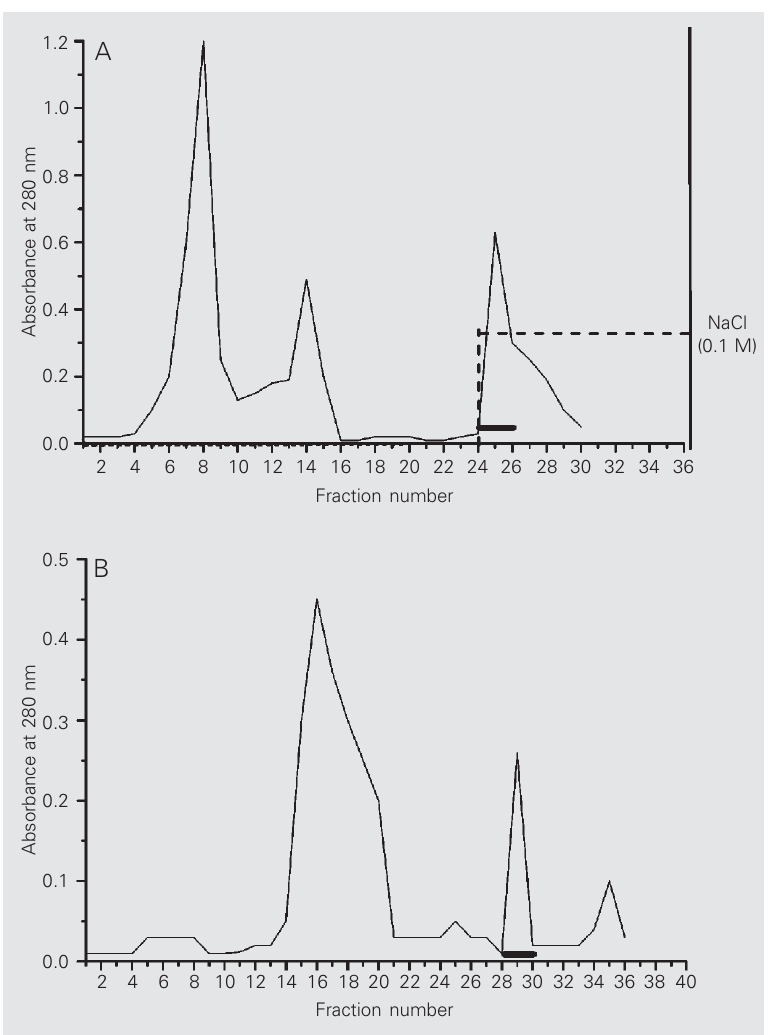
Figure 1. A , DEAE Sepharose Fast Flow column chromatography. A crude sample was